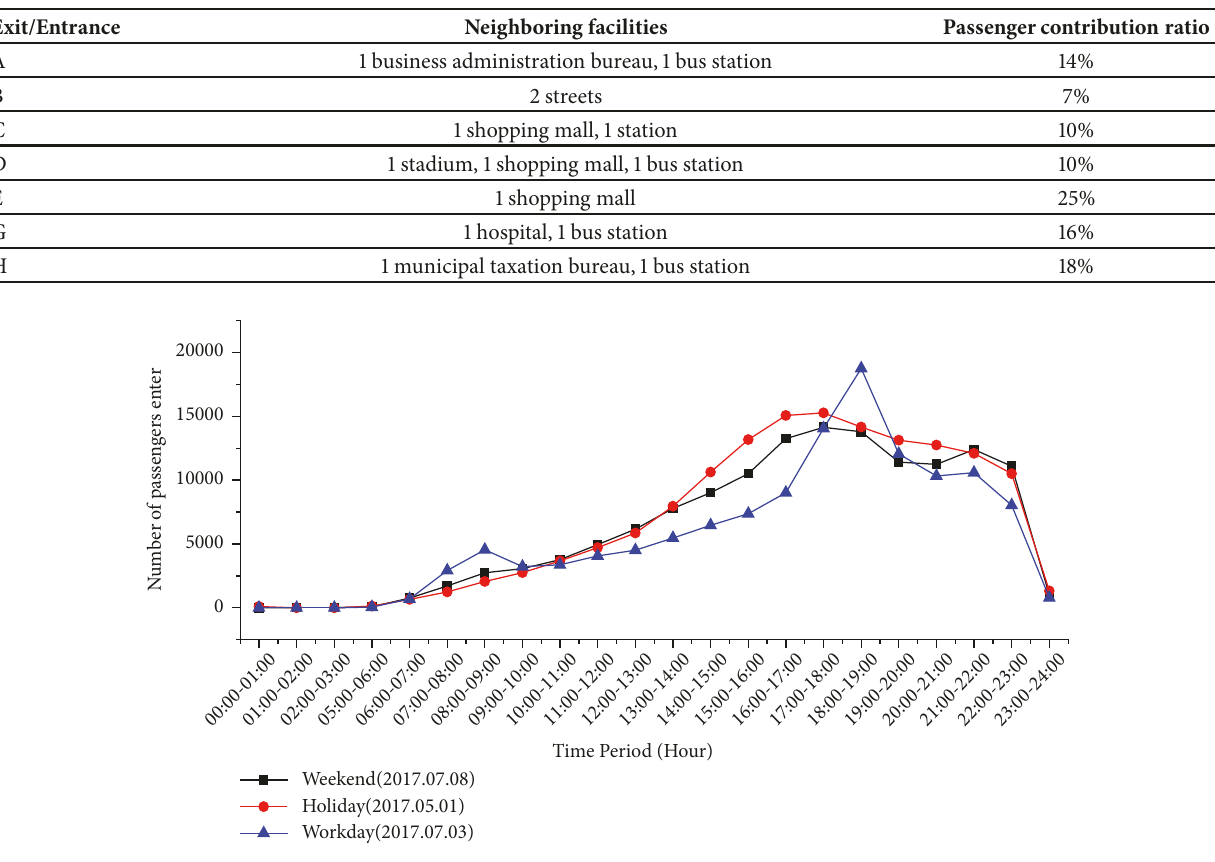
Figure 3: Flow rate of people entering T Station within one